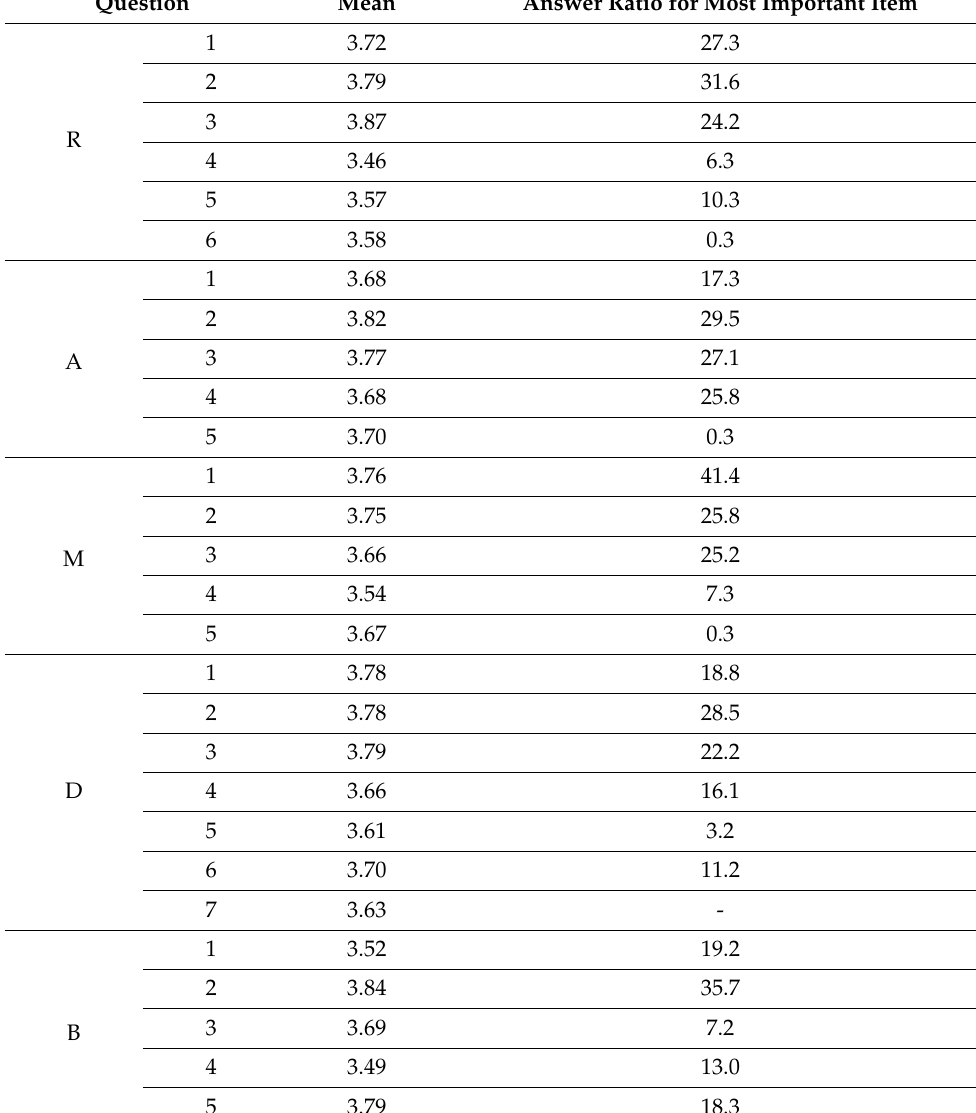
Table A1. Survey Result Summary. (Unit: %, Point/5